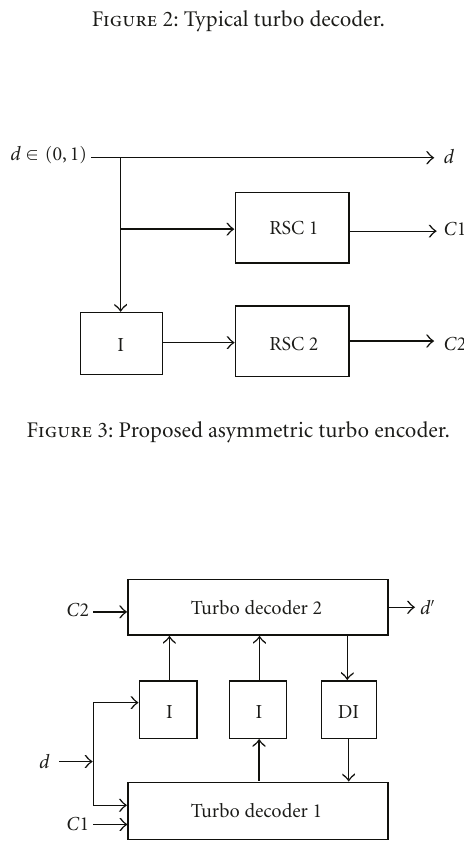
Figure 4: Proposed asymmetric turbo